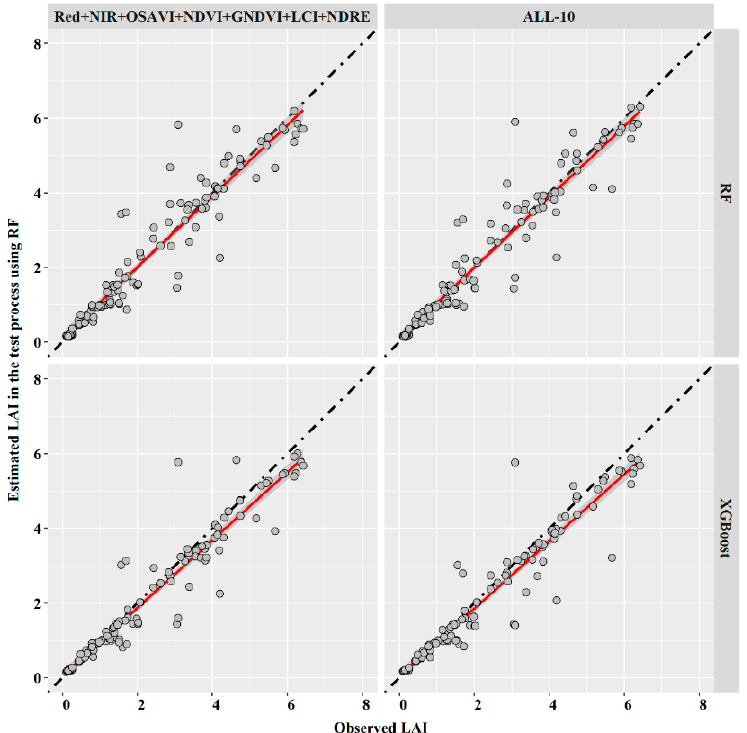
Figure 12. Relationship between observed and estimated leaf area index (LAI) of rice by random forest model (RF) and Extreme Gradient Boosting model (XGBoost) with multispectral bands (B) and vegetation indexes (VIs) in the test process. Dash lines and red solid lines are the 1:1 lines and the linear fitting lines, respectively. The shaded areas indicate the range of 95% prediction bands. Table 4. Statistical evaluation for RF and XGBoost with multispectral bands and vegetation indexes (VIs) as input variables. Vegetation Indexes